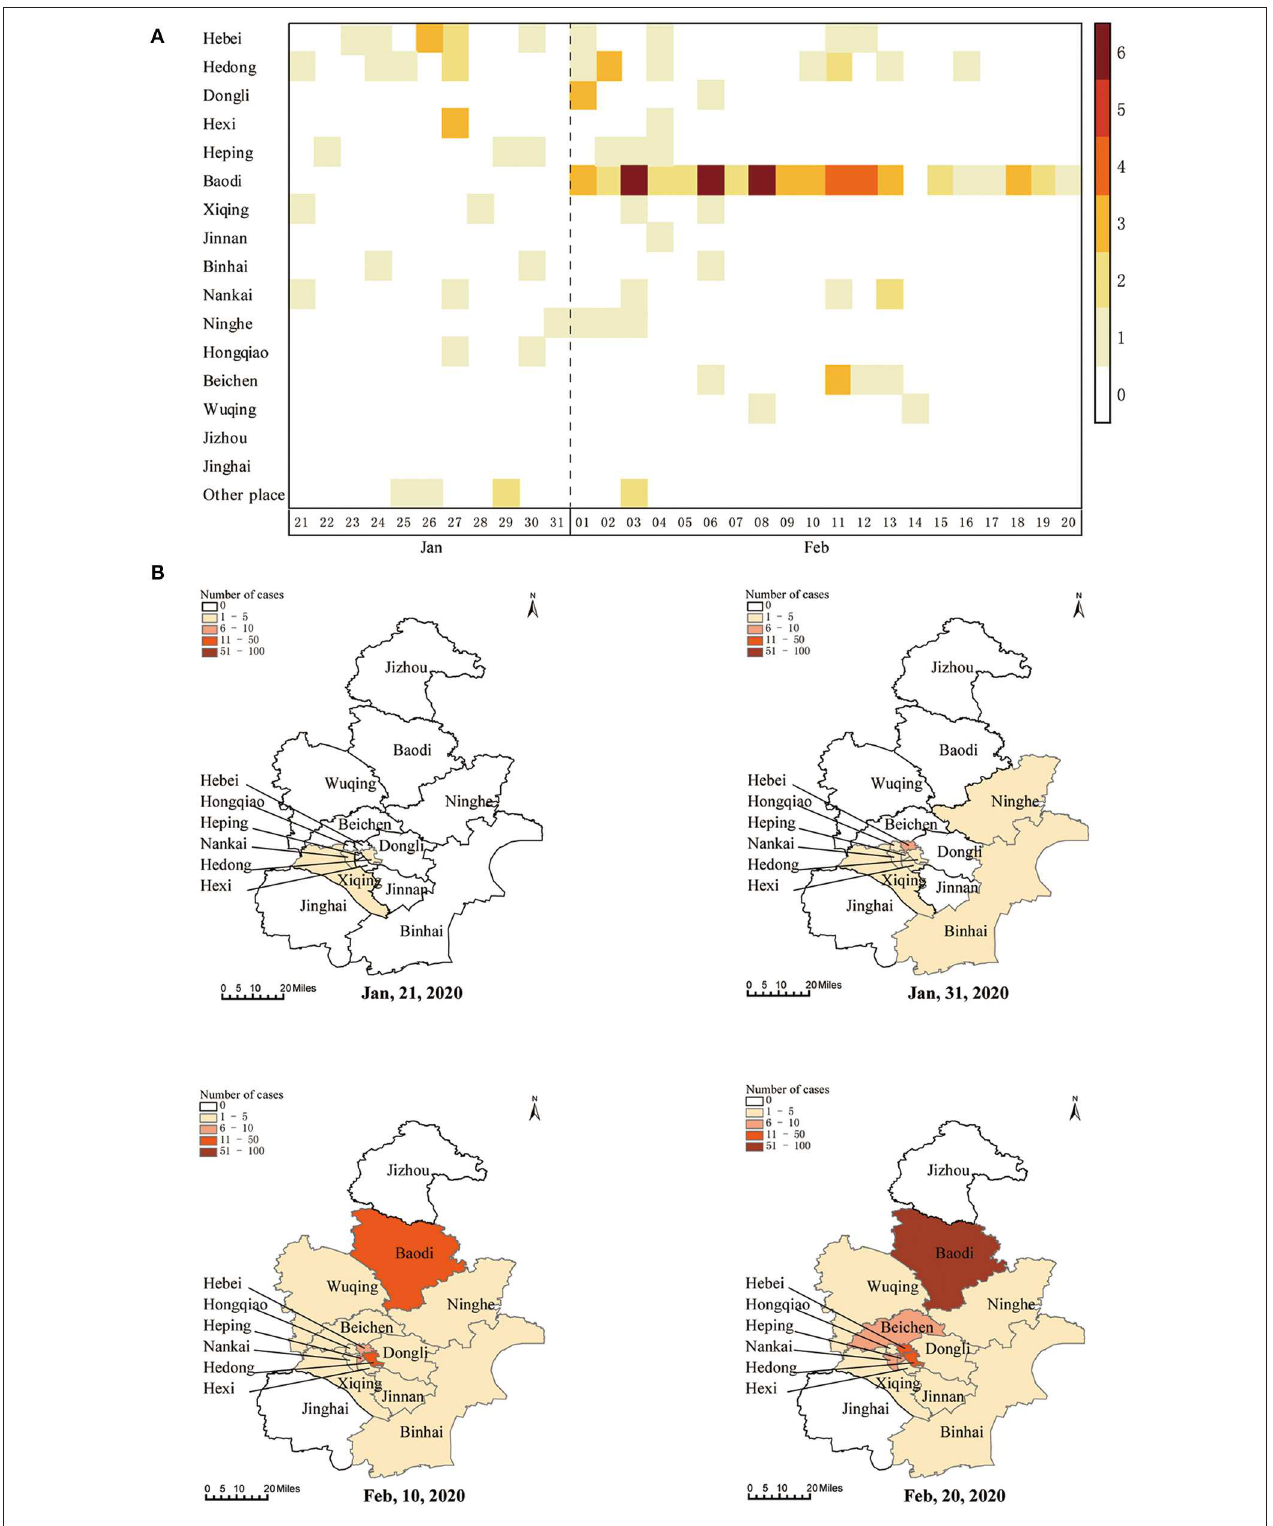
FIGURE 2 | Spatial distributions of confirmed COVID-19 cases in Tianjin. Daily number of new infections in each district (A) and cumulative number of cases on map by the end of January 21, 2020, January 31, 2020, February 10, 2020, and February 20, 2020 (B) .